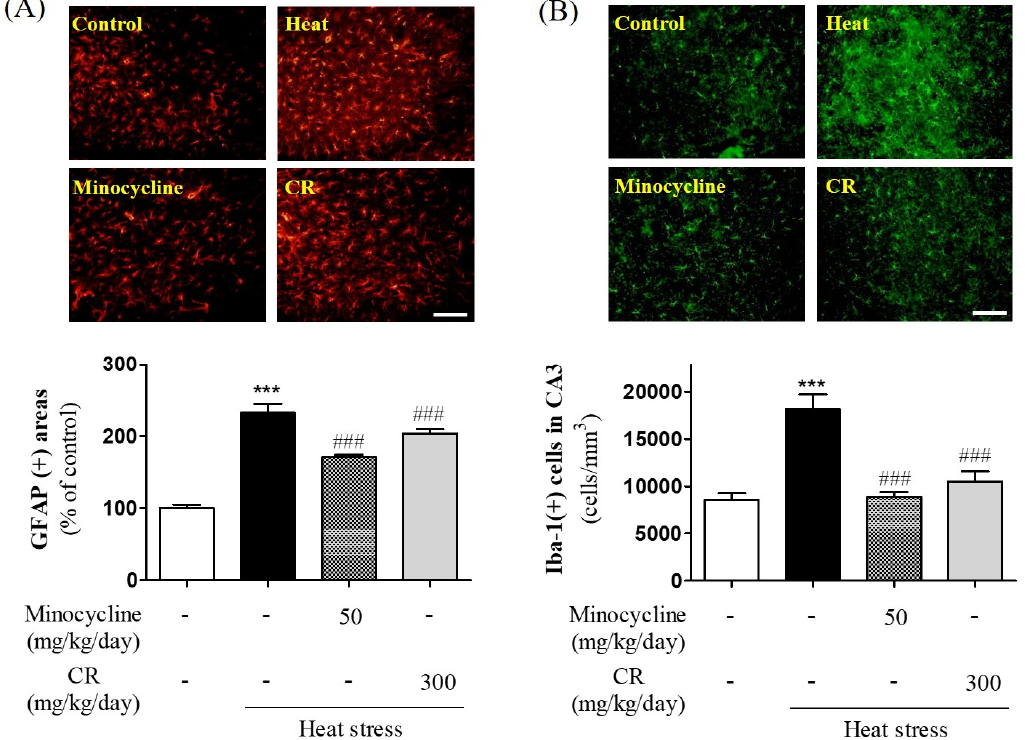
Figure 5. Inhibitory effects of CR on heat stress ‐ induced neuroinflammation in hippocampus of mice.